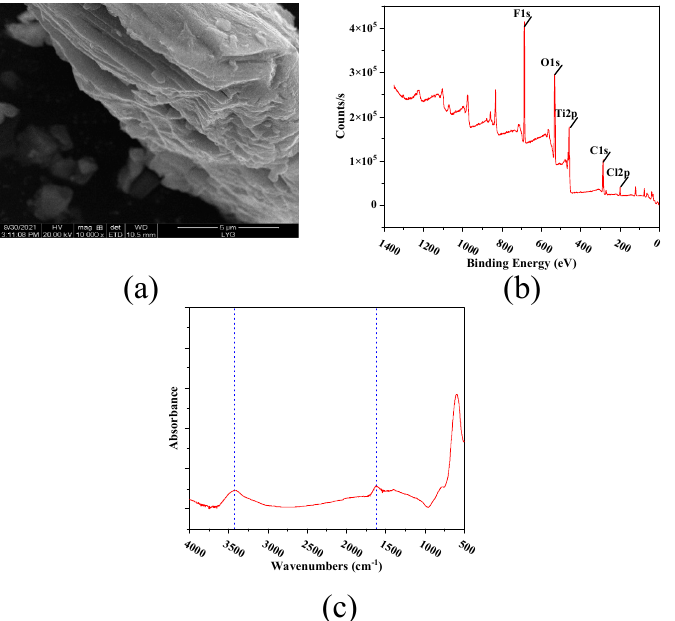
Figure 4. The characterization of MXene nano-sheets: ( a ) SEM micrograph, ( b ) XPS spectra, ( c ) Infrared spectrogram in the range of 400–4000 cm − 1 .